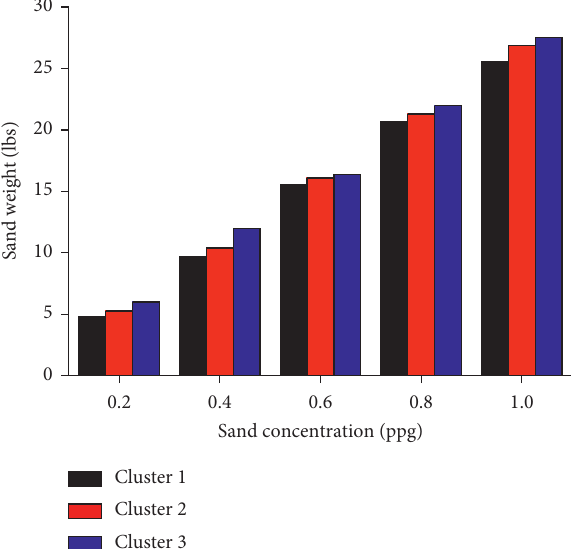
Figure 4: Sand distribution along perforation clusters at a pumping rate of 80 gallons/minute.